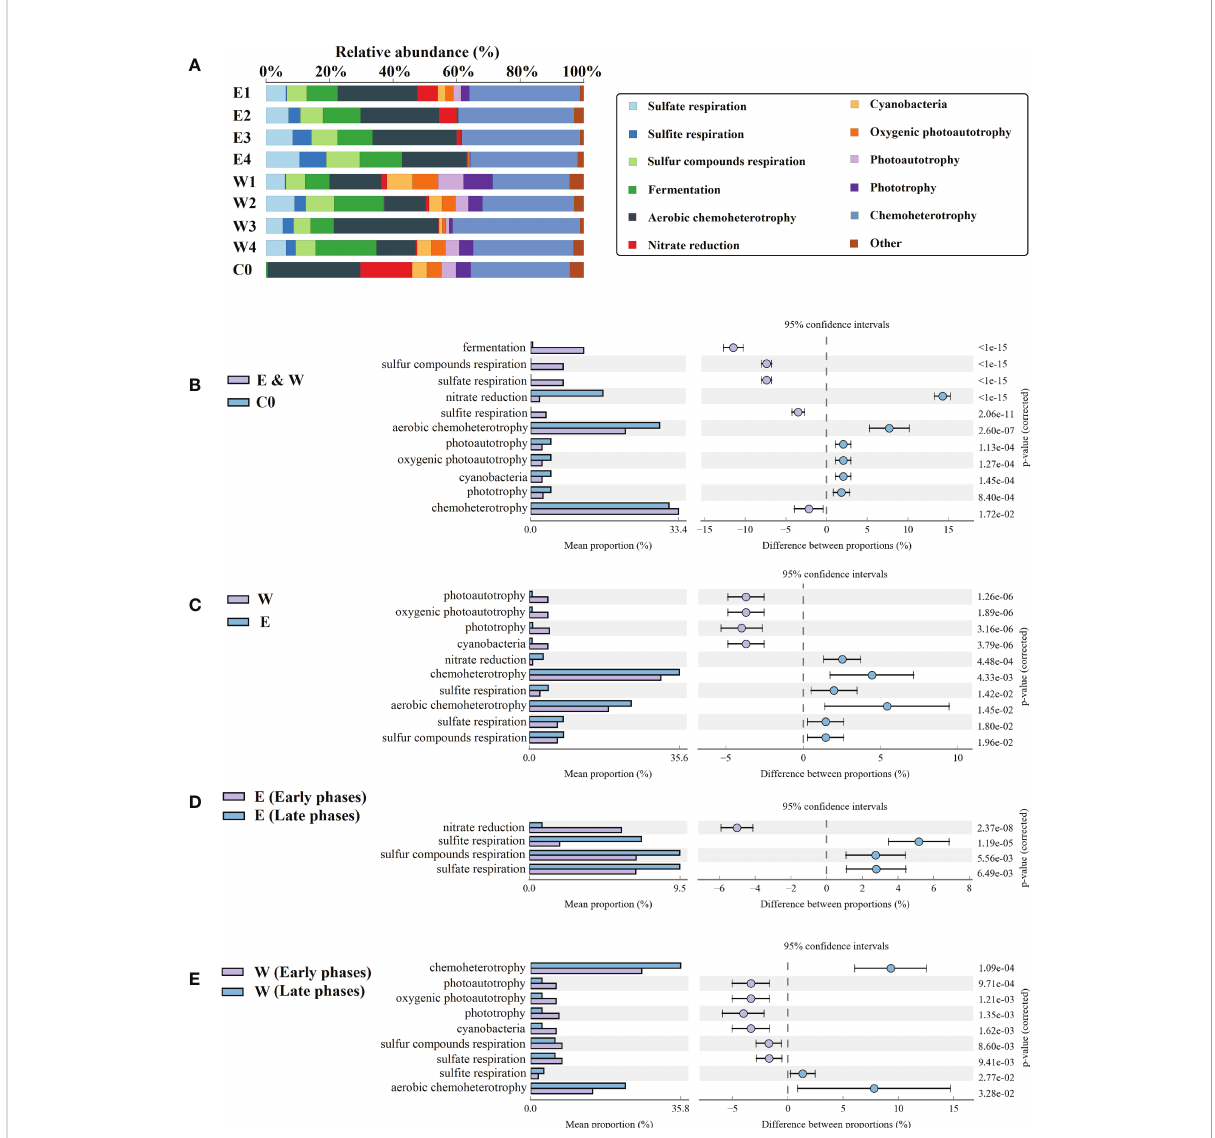
FIGURE 7 The potential functional taxa in sample groups. (A) The potential functional taxa with relative abundance above 1.00%. (B – E) The potential functional taxa with signi fi cant differences in abundance between different sample groups. E and W refer to the epiphytic and phycospheric seawater bacterial sample groups, respectively. The numbers 1 to 4 refer to the P1 to P4 phases, respectively. C0 refers to the control seawater bacterial sample groups. Others: sum of functional taxa with a relative abundance below